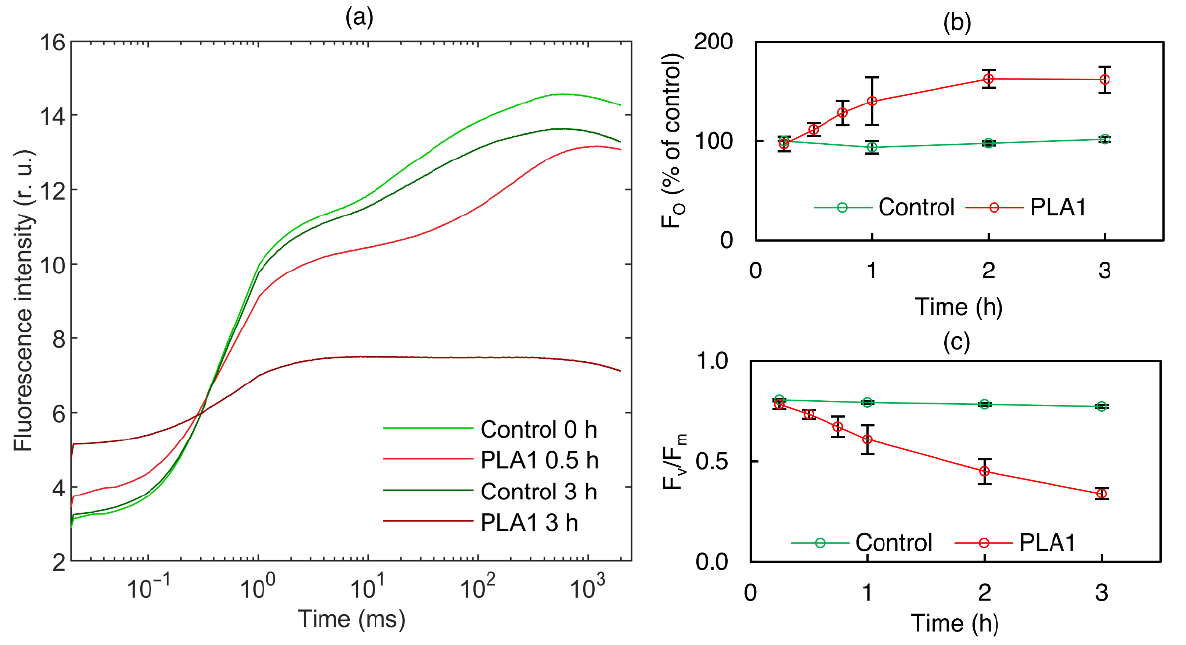
Figure 4. ( a ) Typical fast Chl- a fluorescence (OJIP) transients of isolated spinach thylakoid membranes untreated (light green—0 min; dark green—3 h) and treated with 2 U mL − 1 PLA1 (light red—30 min; dark red—3 h). ( b , c ) Time dependences of Chl- a fluorescence induction parameters F o and F v /F m , respectively; untreated (green) and treated with 2 U mL − 1 PLA1 (red). Mean values and standard deviations are from three independent experiments.